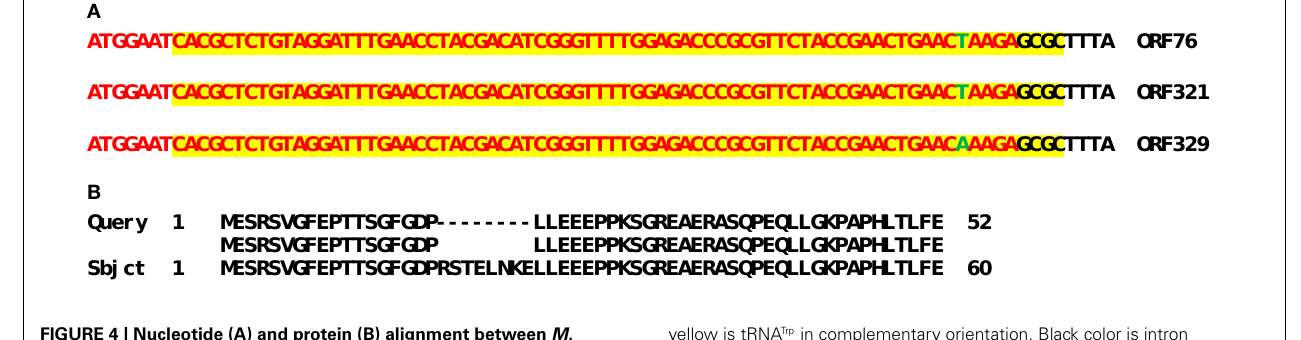
FIGURE 4 | Nucleotide (A) and protein (B) alignment between M. truncatula nuclear putative ORF76, ORF321, and ORF329 and Vicia faba mitochondrial gene tRNA Trp . (A) A nucleotide sequence of exon 1 (red color) in putative ORF76, ORF321, and ORF329 (NCBI BLAST). Highlighted with